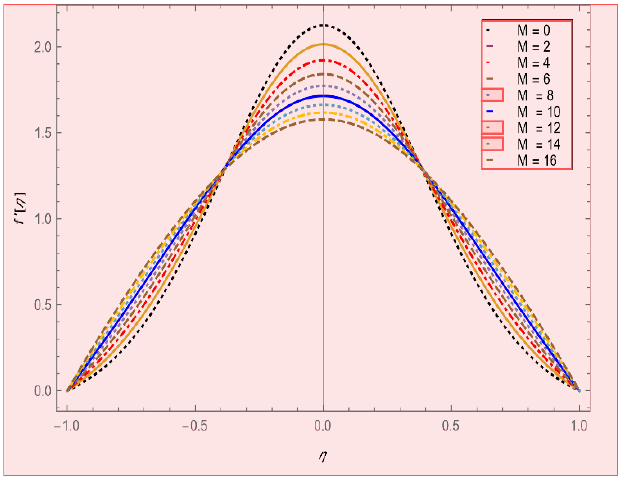
Figure 8. Radial velocity profile for 𝜑 1 = 𝜑 2 = 0.01, 𝛼 = 1,𝑅𝑒 = −1.